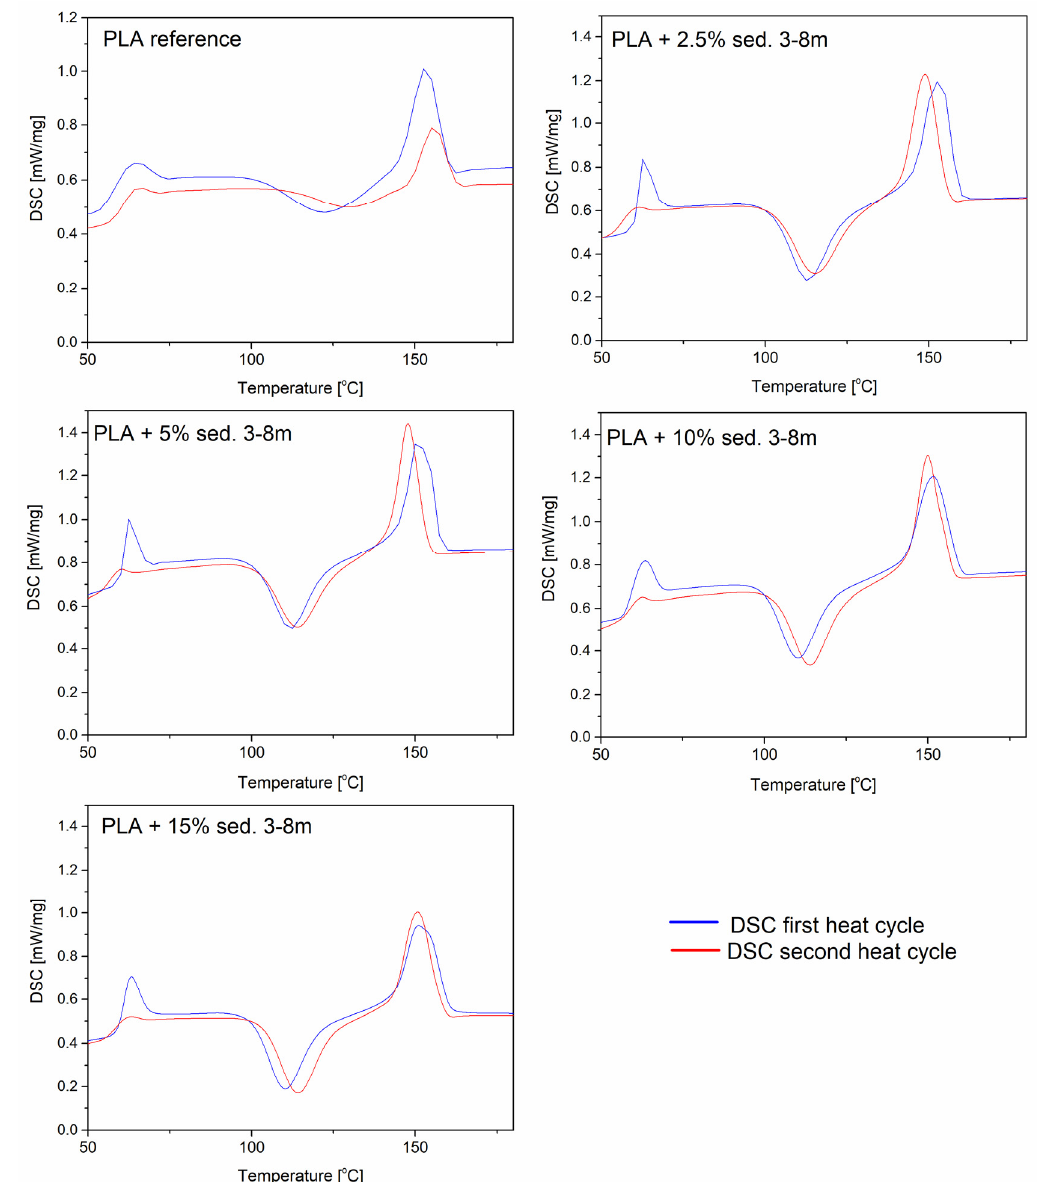
Figure 7. DSC plots of PLA/sedA.